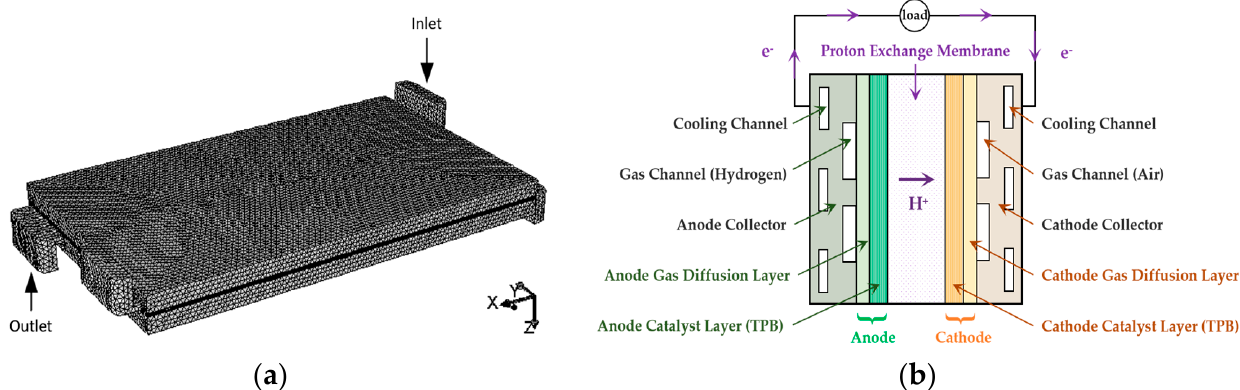
Figure 1. Schematic diagram of the meshing employed for computational domain ( a ) and geometry configuration ( b ).